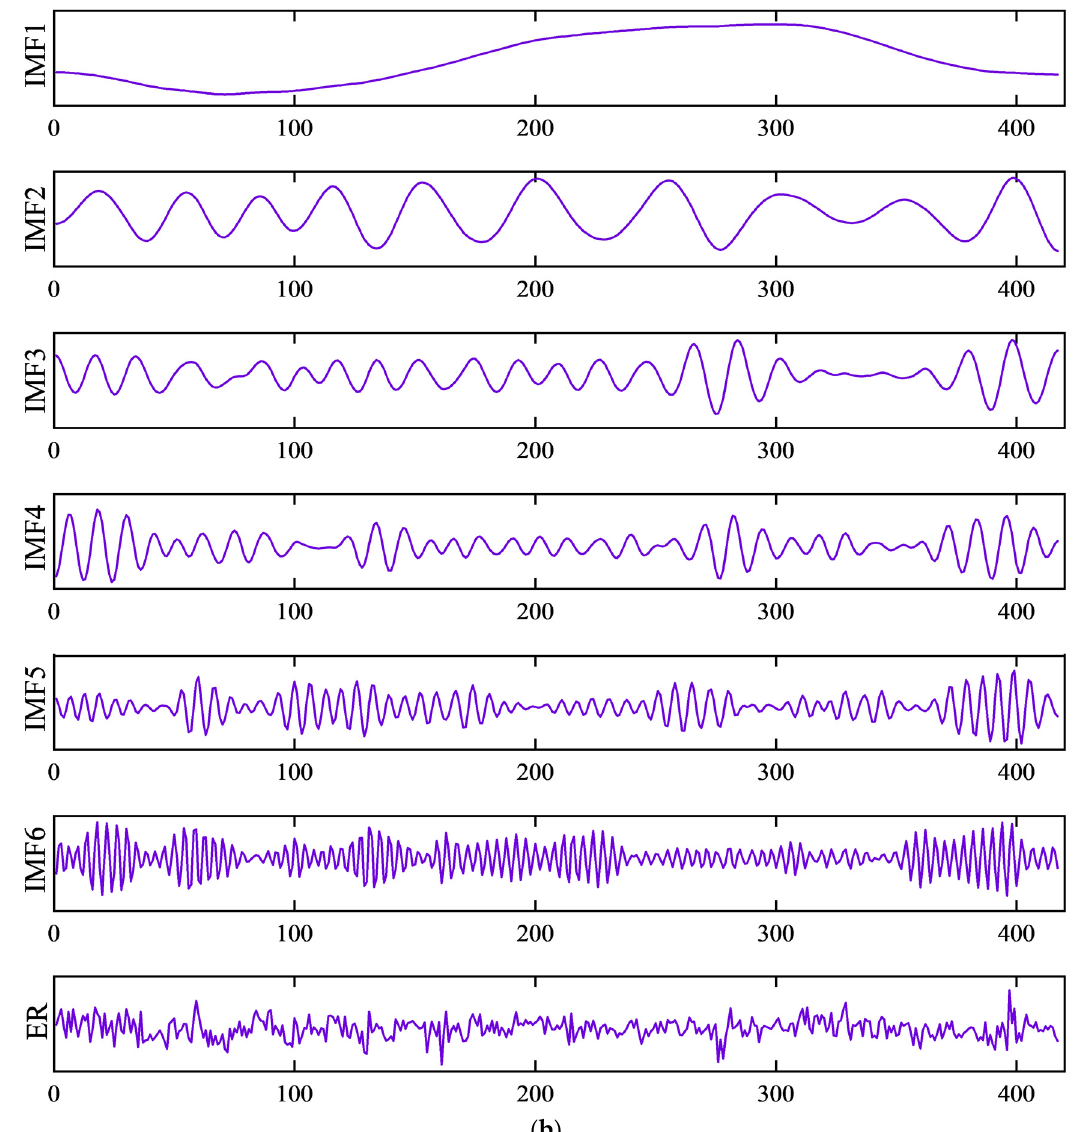
Figure 8. Decomposition result of VMD measuring point deformation sequence(( a ) EX5, ( b ) EX2).